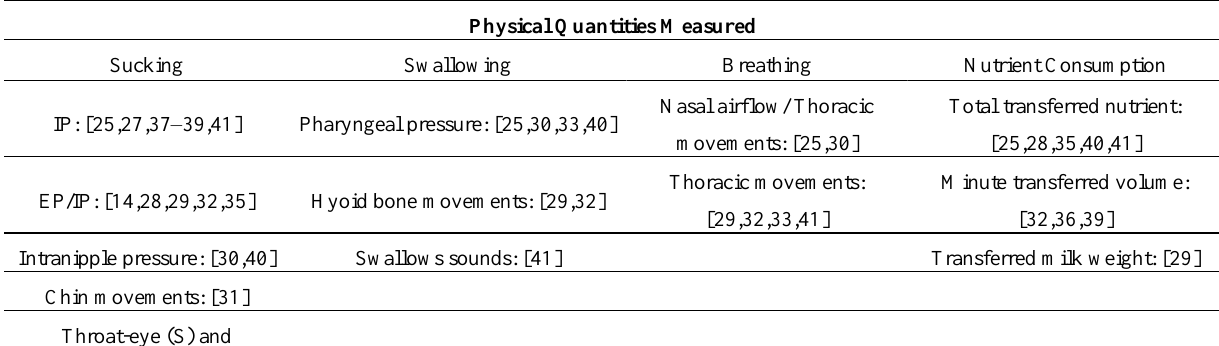
Table 2. Overview of the physical quantities measured to monitor the NS